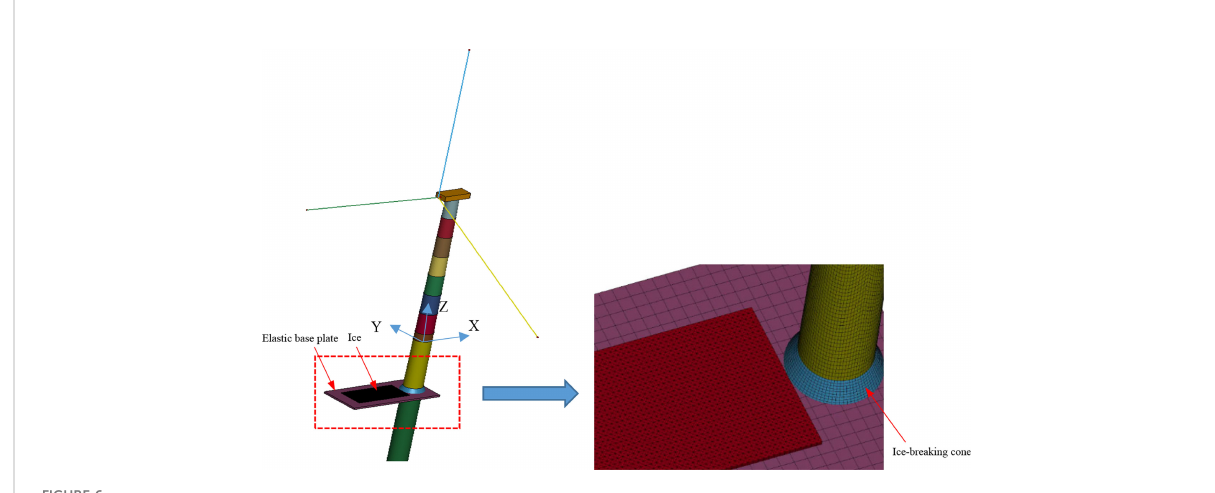
FIGURE 6 Ice – OWT interaction coupling